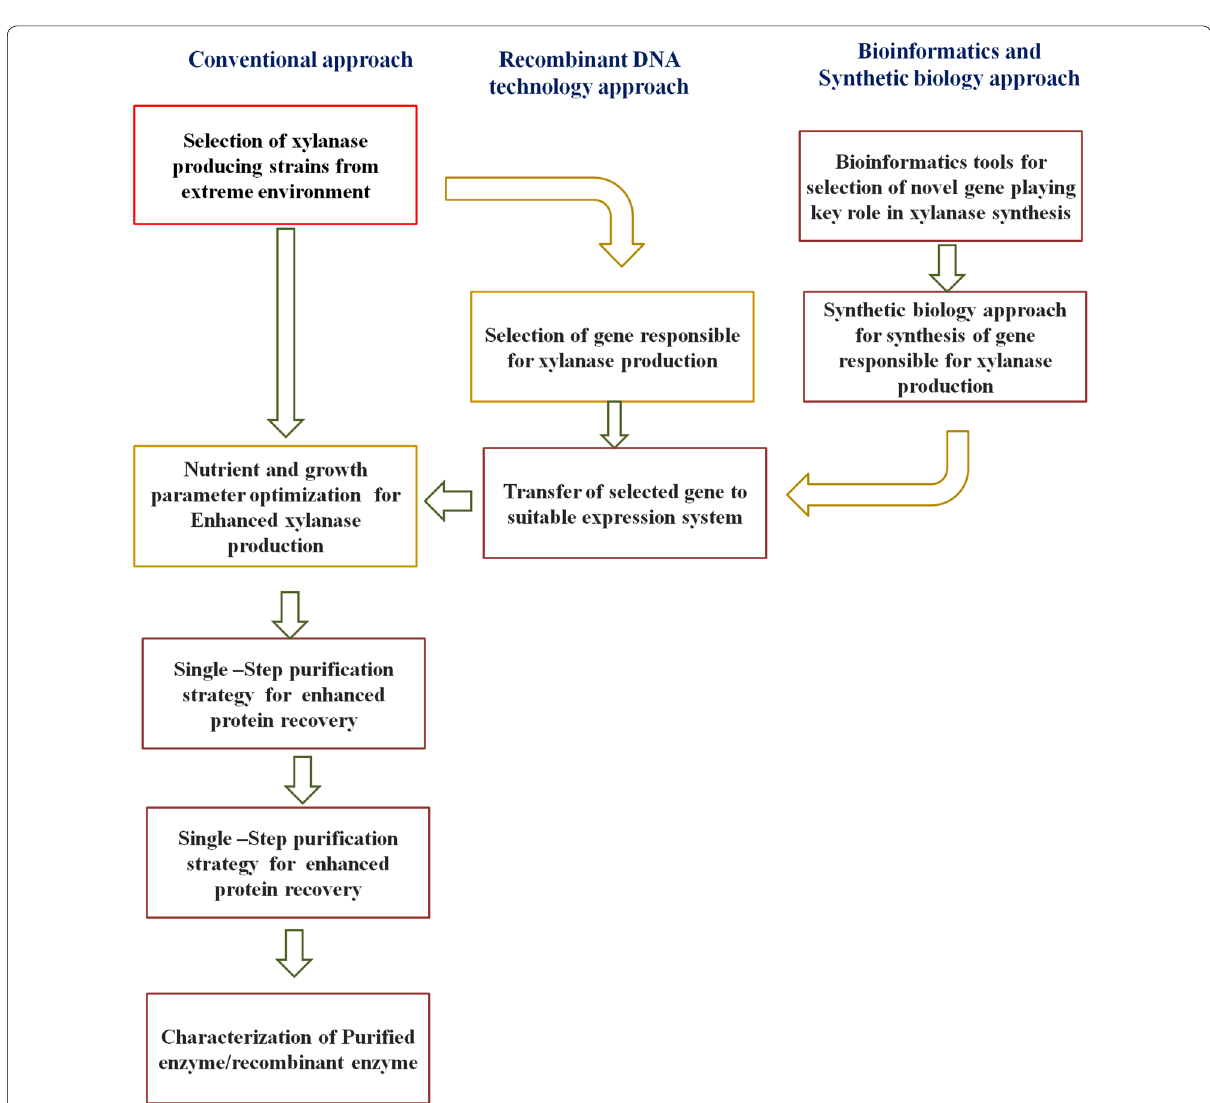
Fig. 7 Future prospect for development in area of xylanase production using conventional and advanced